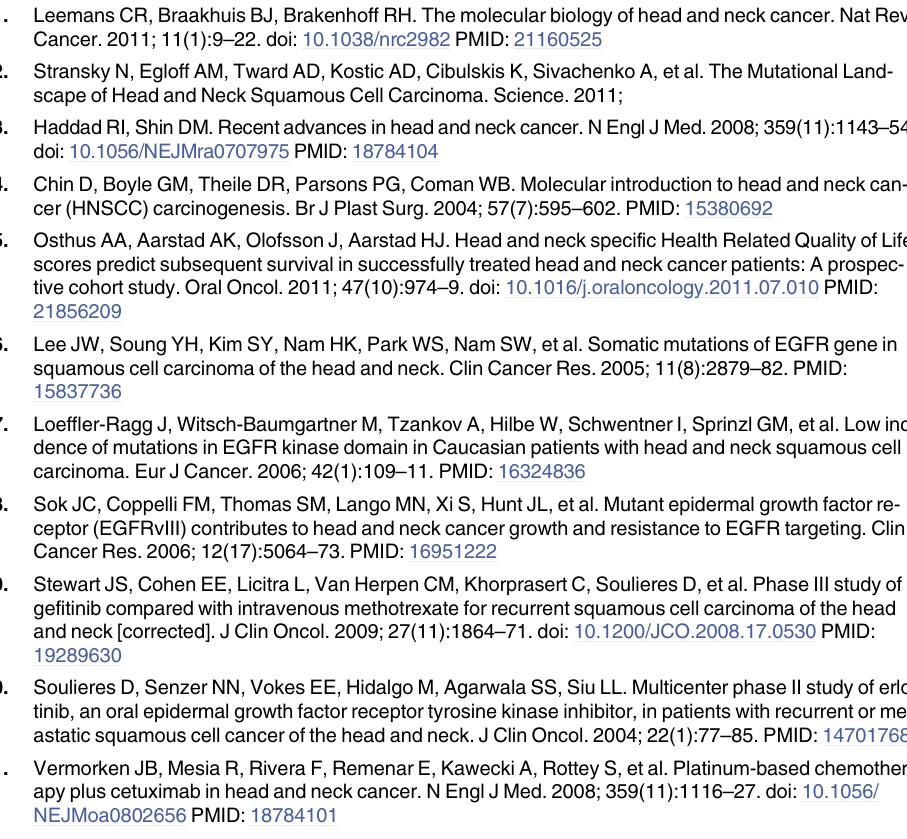
S3 Fig. Phospho-Smad2 is not increased in TKI-treated UMSCC25 cells. UMSCC25 cells were treated for 4 days with DMSO-control, 0.3 μ M AZD4547, 0.1 μ M gefitinib, or the combina- tion. Cell lysates were submitted to SDS-PAGE, and filters were probed for pSmad2 and total Smad2/3. No increase in pSmad2 was observed after incubation with TKIs. Na + /K + ATPase was used as a loading control. S4 Fig. Original Immunoblots. These are the original, uncropped western blots with the lad- ders that are seen in S3